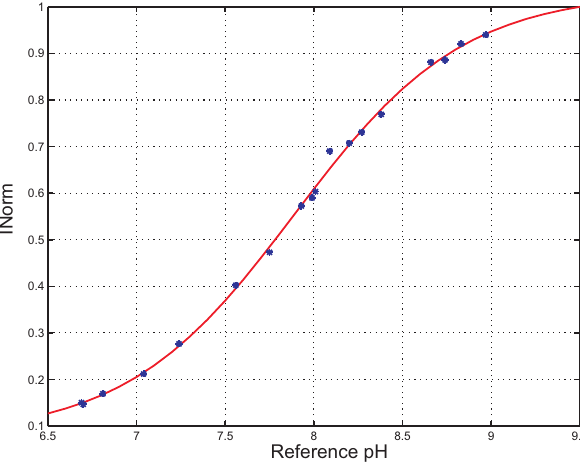
Figure 8. I versus reference pH and sigmoidal interpolation Norm